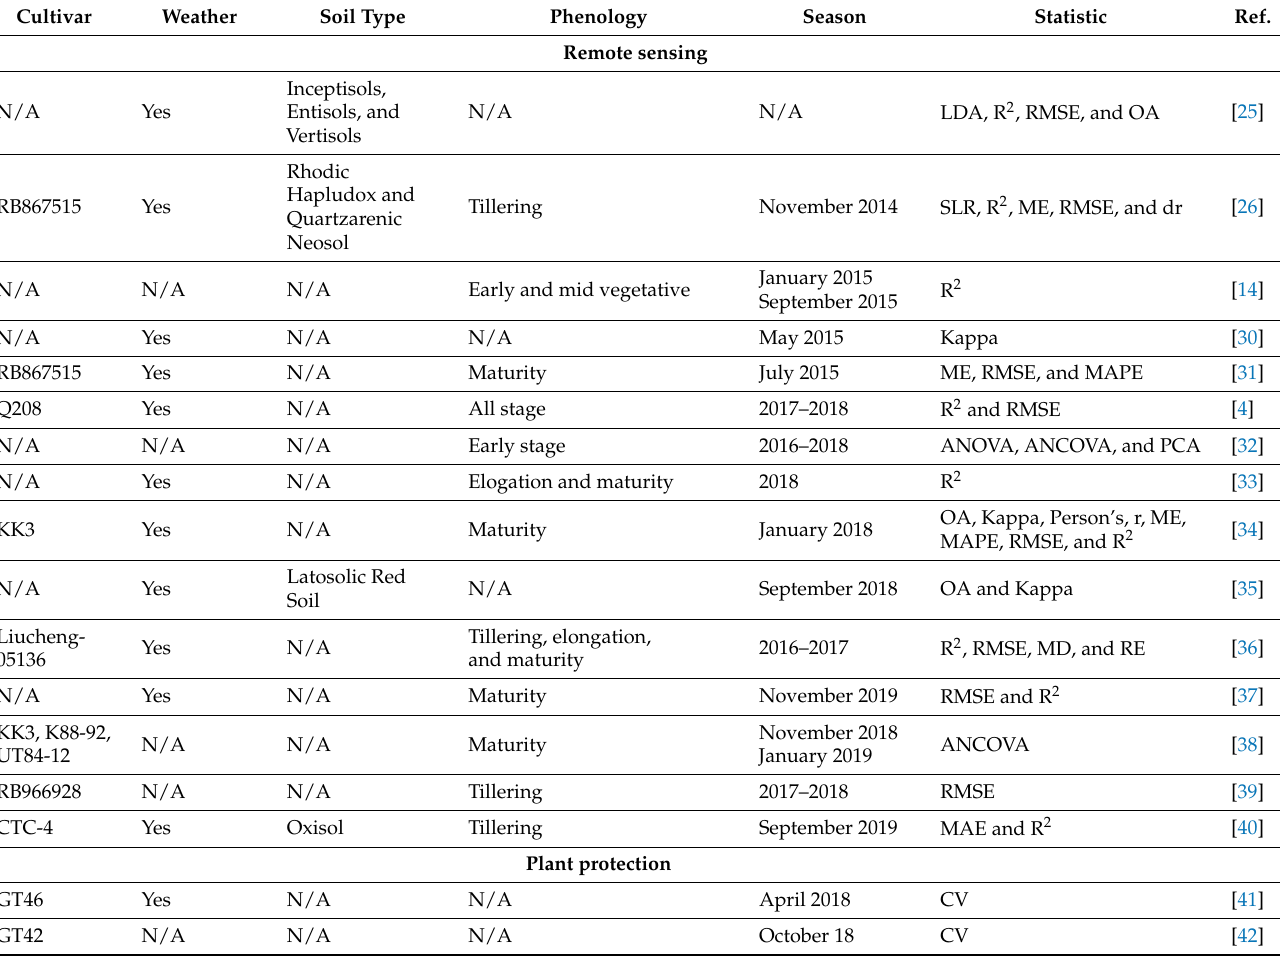
Table 3. State-of-the-art of operating UAVs to monitor and manage